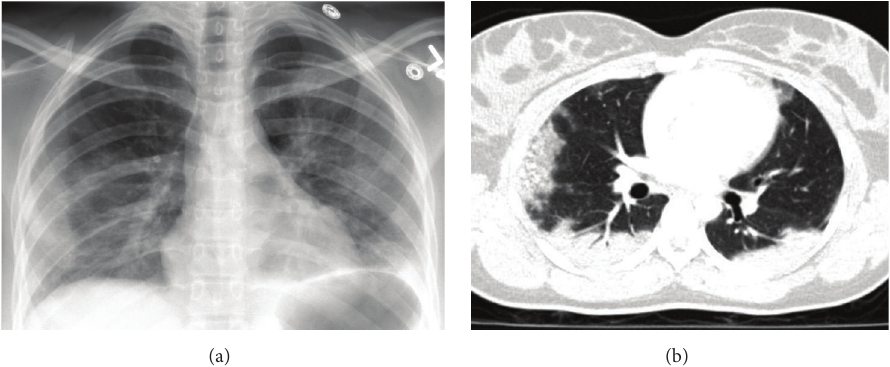
Figure 1: (a) Portable chest X-ray showing bilateral lung opacities with relative sparing of the right upper lobe and left pleural effusions. (b) CT scan of chest showing multifocal and bilateral, predominantly peripheral airspace opacities.